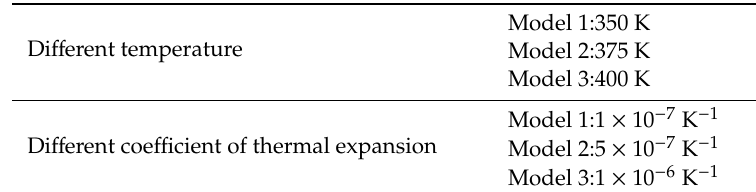
Table 1. Numerical simulation scheme for heat injection.